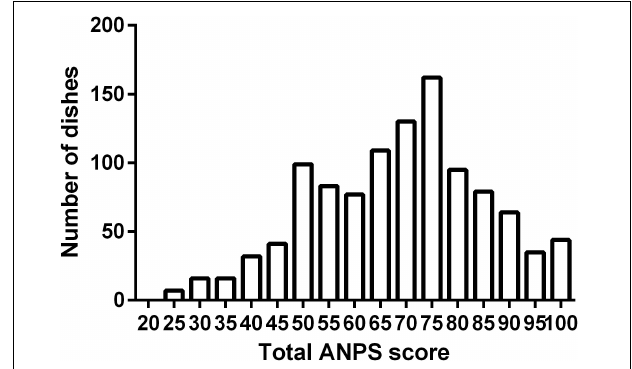
FIGURE 3 | Distribution of total dishes score using the Ajinomoto Group Nutrient Profiling System (ANPS). A total of 1,089 dishes including the regular and low-salt dishes of the Ajinomoto’s recipe website and nutrition calculation software were evaluated using the algorithm indicated in Figure 2 .